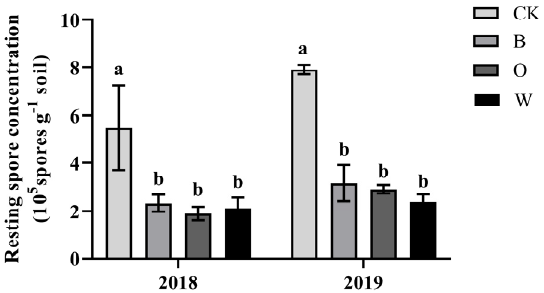
Figure 3. Concentrations of resting spores of plasmodiophora brassicae after preceding crops were harvested. CK represents Chinese cabbage continuous cropping, B, O, and W represent bean, potato onion, and wheat rotation respectively. Different letters are significantly different, the results are for the statistics analysis within each year ( p < 0.05, Tukey’s HSD test).